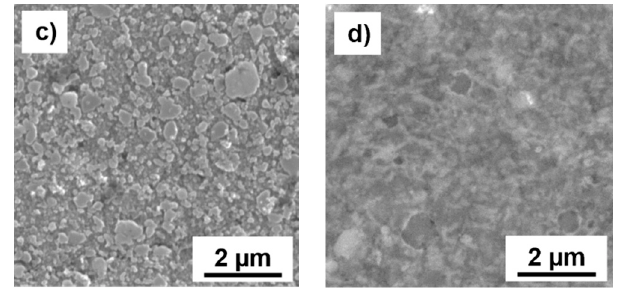
Figure 2. Detailed SEM micrographs of: ( a , b ) Al-20Si-10Fe-6Cr; ( c , d ) Al-20Si-10Fe-6Mn alloys prepared by short-term MA ( a , c ) and compacted by SPS ( b , d ).